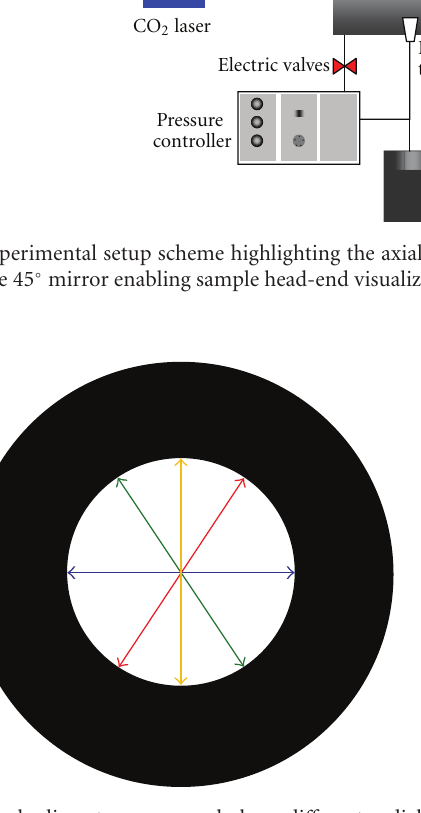
Figure 2: Single diameters measured along di ff erent radial direc-